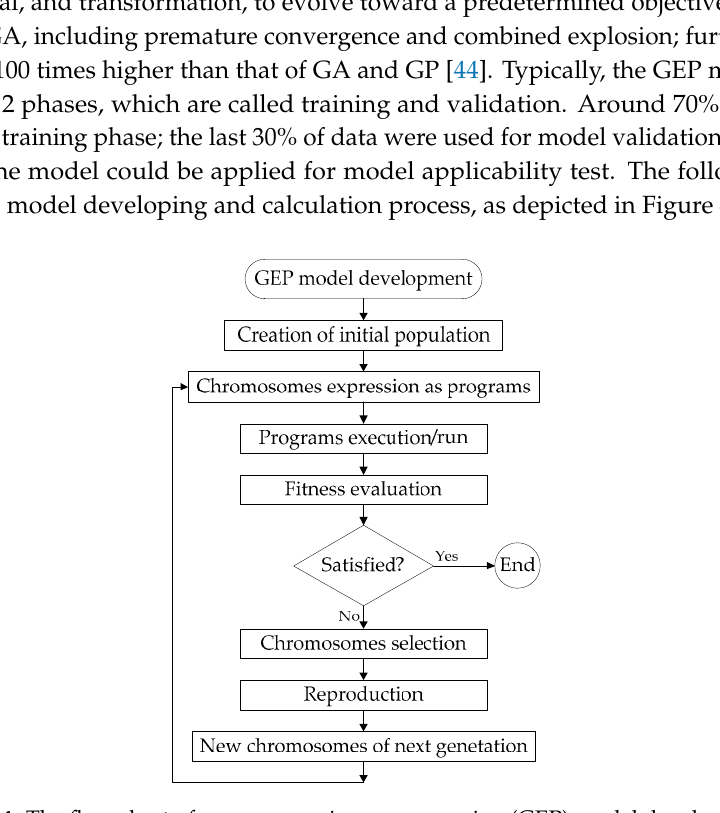
Figure 4. The flow chart of gene-expression programming (GEP) model development.